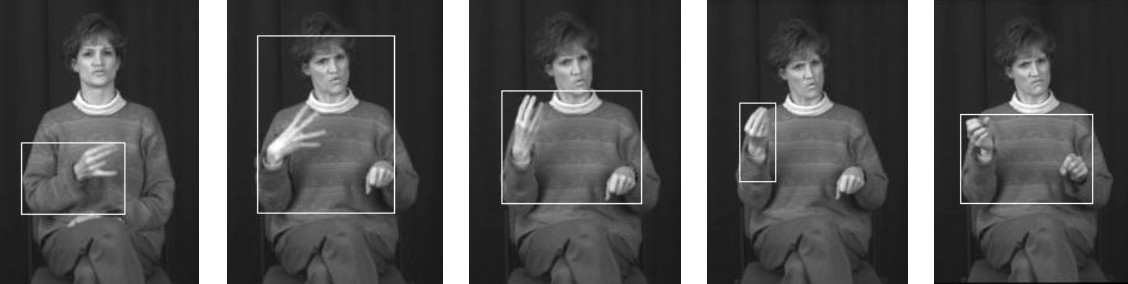
Figure 6. Hand tracking for the usual image by applying just motion detection algorithm.